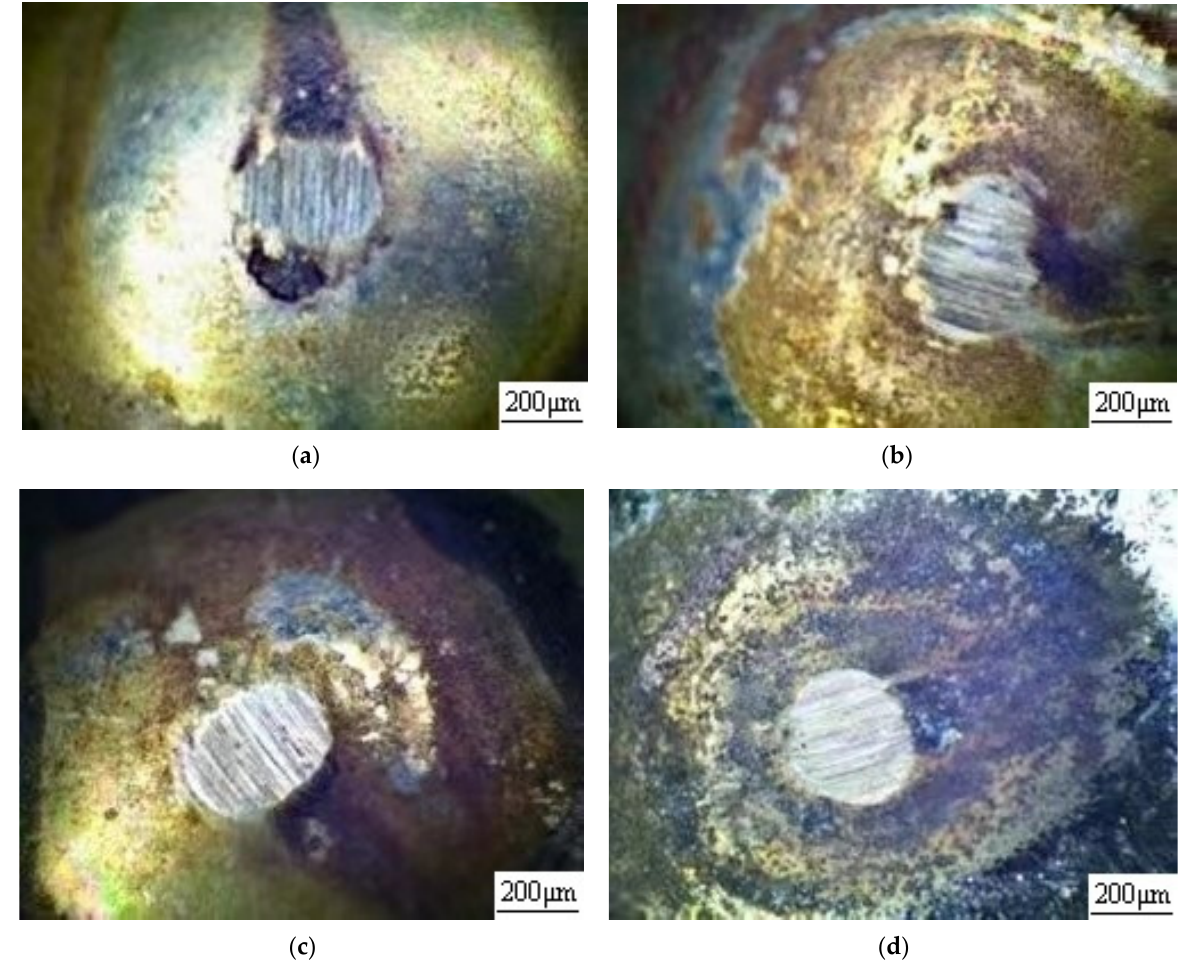
Figure 6. Wear marks of grease after freeze–thaw: ( a ) PTFE; ( b ) Graphene; ( c ) CNTs; ( d ) WS 2 .